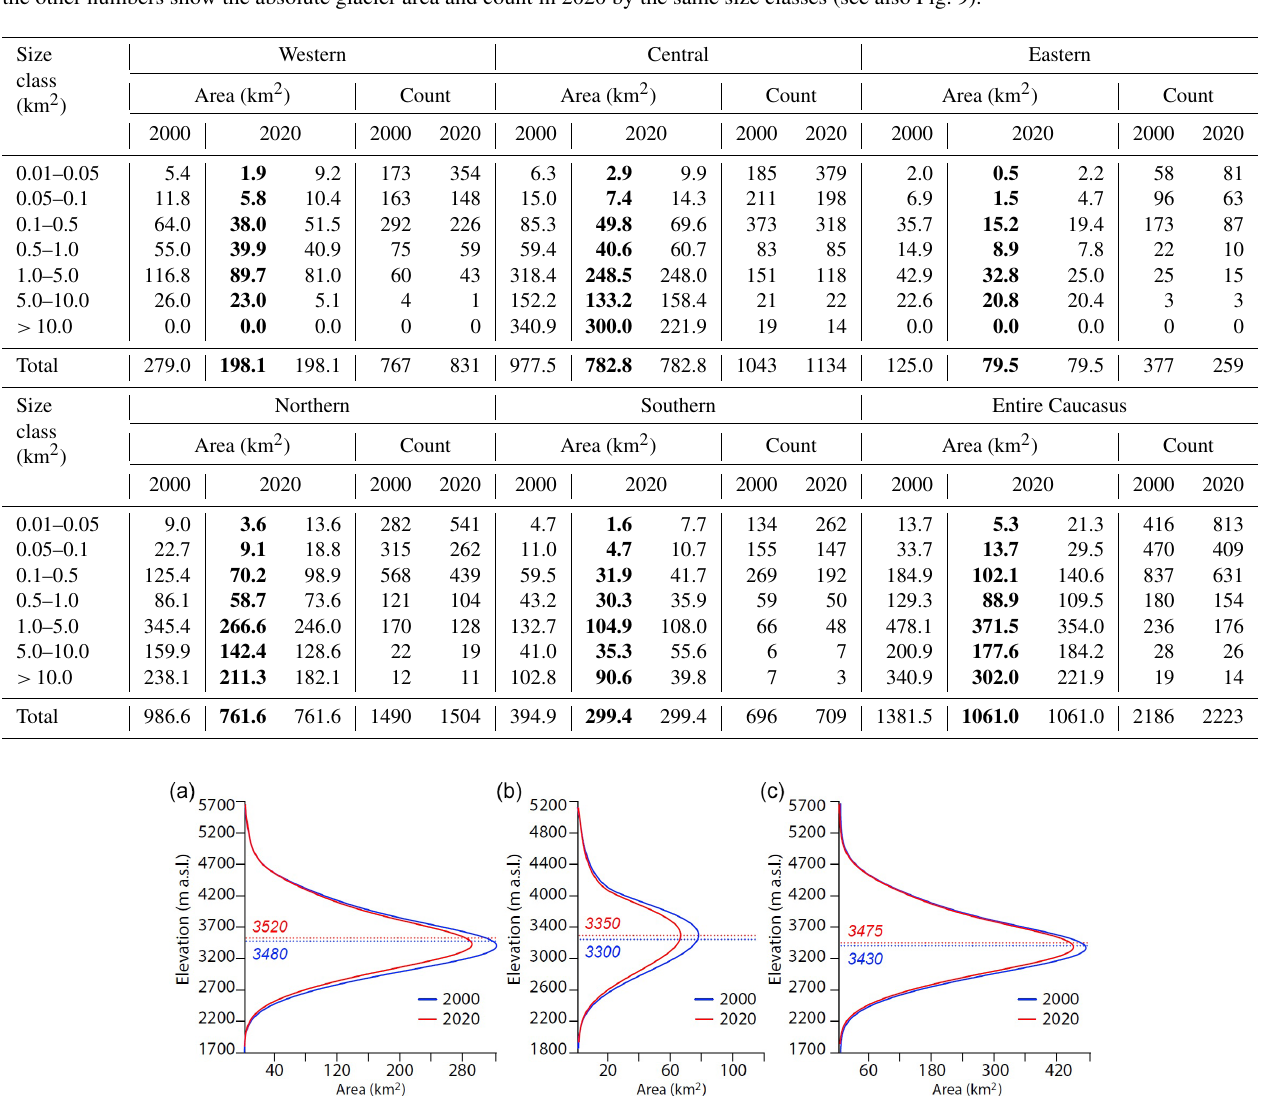
Figure 5. The histogram of glacier area distribution along with mean elevation (dotted line) in 2000 and 2020 for (a) the northern, (b) the southern, and (c) the entire Greater